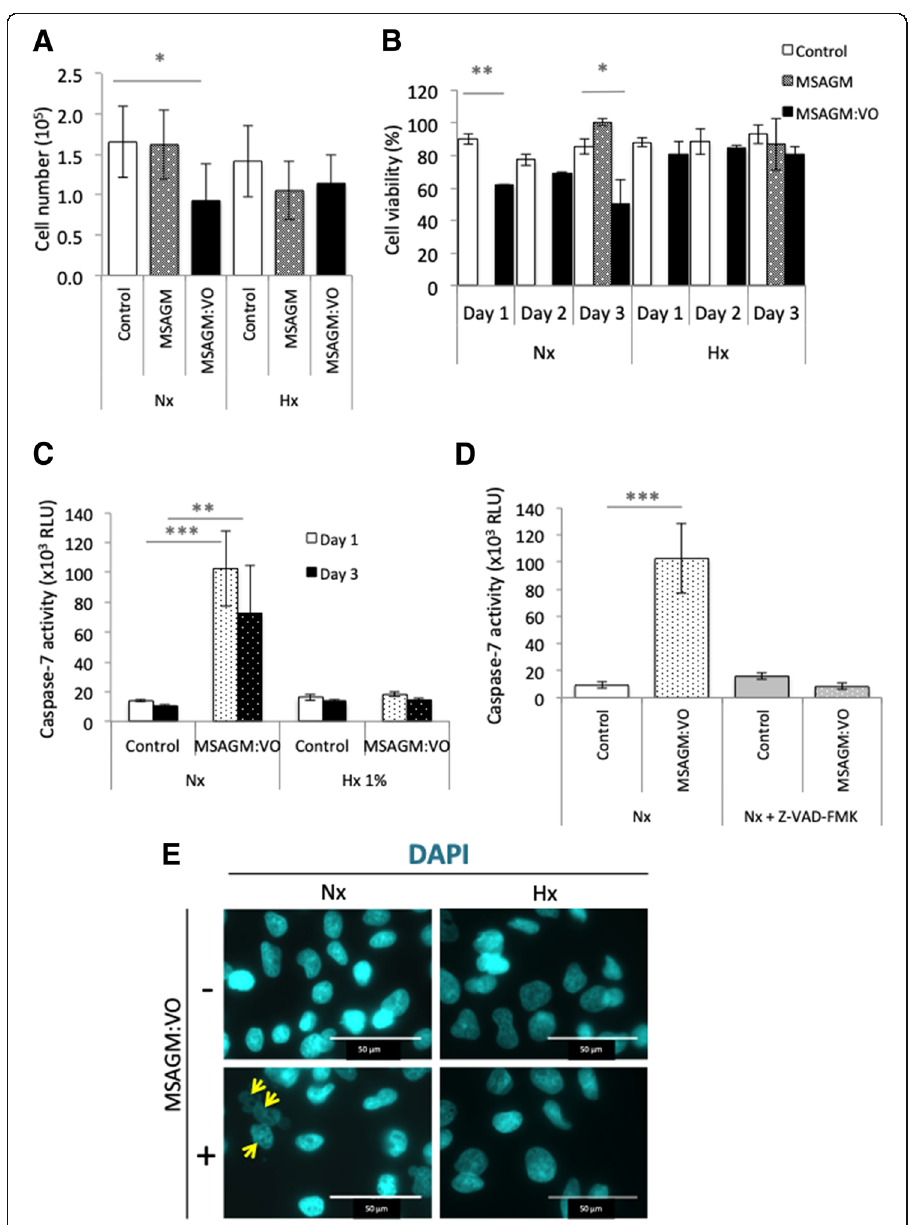
Fig. 1 MSAGM:VO induced apoptosis in normoxia but not in hypoxia in HepG2 cells. a Cells were seeded at the same density and incubated in normoxia (Nx) or hypoxia (Hx 1%) in the absence or presence of MSAGM or MSAGM:VO for 72 h. The means ± SEM are representative of three independent experiments carried out in duplicate. b Cell viability (%) of HepG2 cultured in the absence (Control), or presence of MSAGM or MSAGM:VO for 24 h (day 1), 48 h (day 2) or 72 h (day 3) in (Nx) or (Hx) was measured with an automatic cell counter. c HepG2 cells were incubated in Nx or Hx 1% for 24 h (day 1) or 72 h (day 3) and challenged with MSAGM or MSAGM:VO. Apoptosis was evaluated from the level of caspase-7. d HepG2 cells were incubated in Nx for 72h with MSAGM:VO in the absence or presence of Z-VAD-FMK, an inhibitor of apoptosis. Apoptosis was evaluated from the level of caspase-7. e HepG2 cells were incubated in Nx or Hx for 72h and challenged with MSAGM:VO. Cells were stained with DAPI (blue) to highlight the nucleus and its morphology. Arrows show blebbing in HepG2 cells in Nx in the presence of MSAGM:VO. DAPI: 4 ′ ,6-diamidino-2-phenylindole; RLU: relative luciferase units. * p <0.05, ** p <0.005, *** p